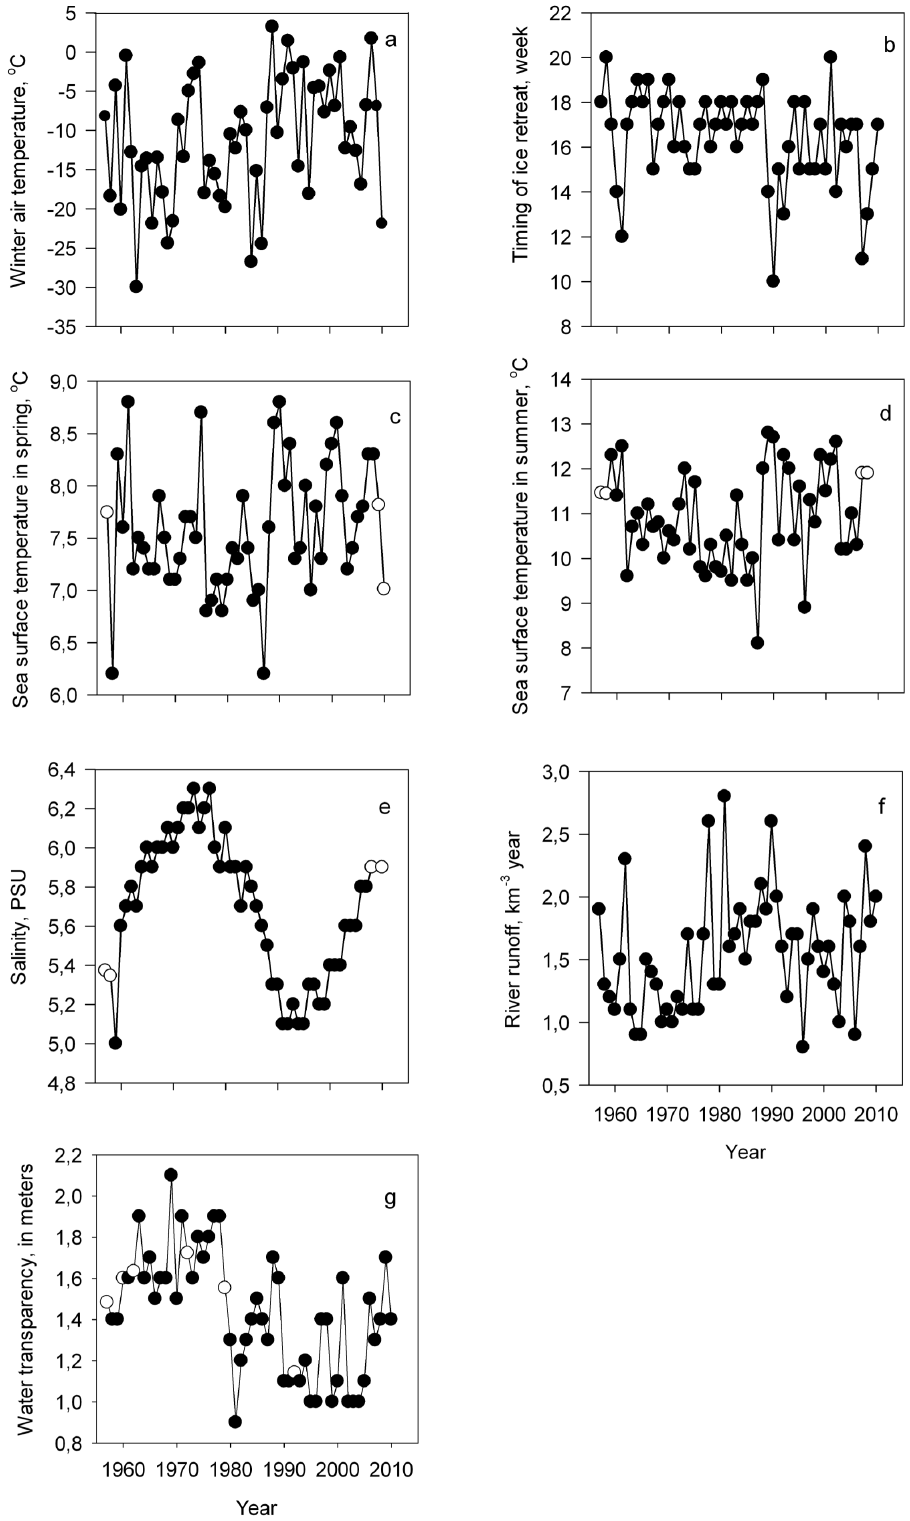
Figure 2. Long term dynamics of hydroclimatic variables as winter air temperature (a), timing of ice retreat (b), mean sea surface temperature in spring (c), mean sea surface temperature in summer (d), mean sea surface salinity in summer (e), mean annual river runoff (f), water transparency in summer (g). Empty dots denote the year when missing value replacement procedure was applied.